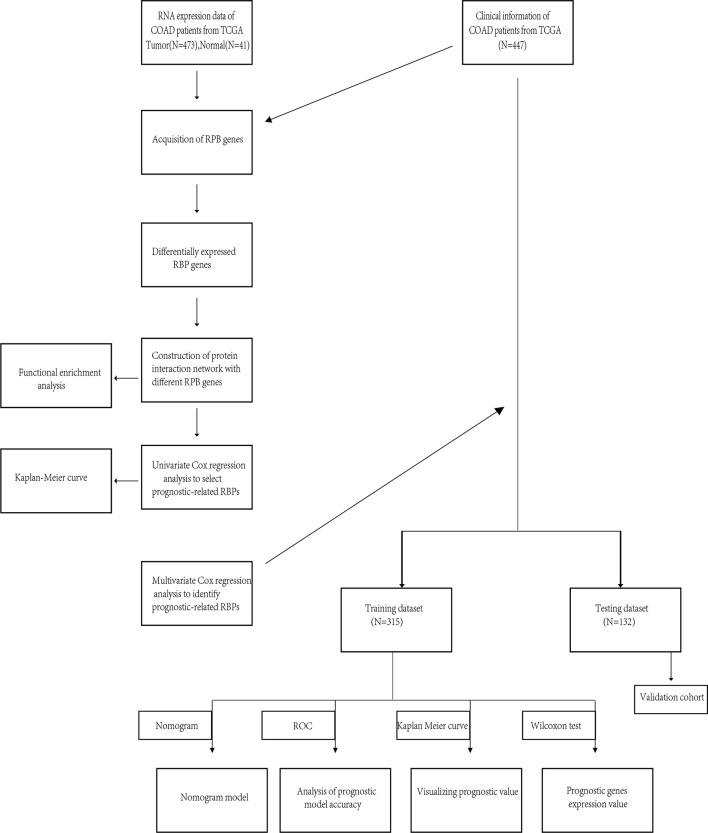
Whole procedures for analyzing RBPs in COAD.